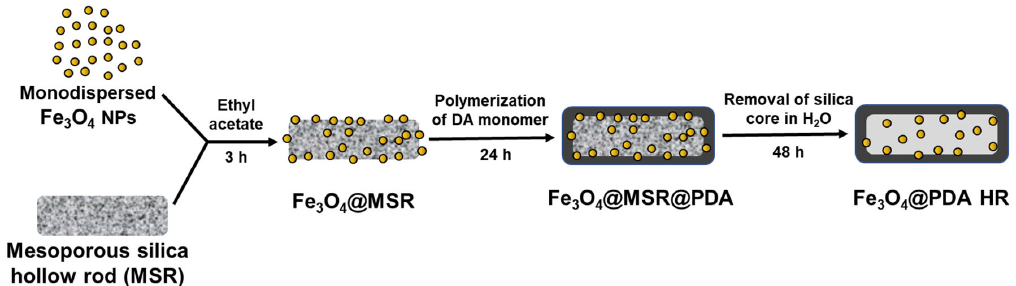
Figure 1. Schematic illustration for the preparation of Fe 3 O 4 NPs filled PDA